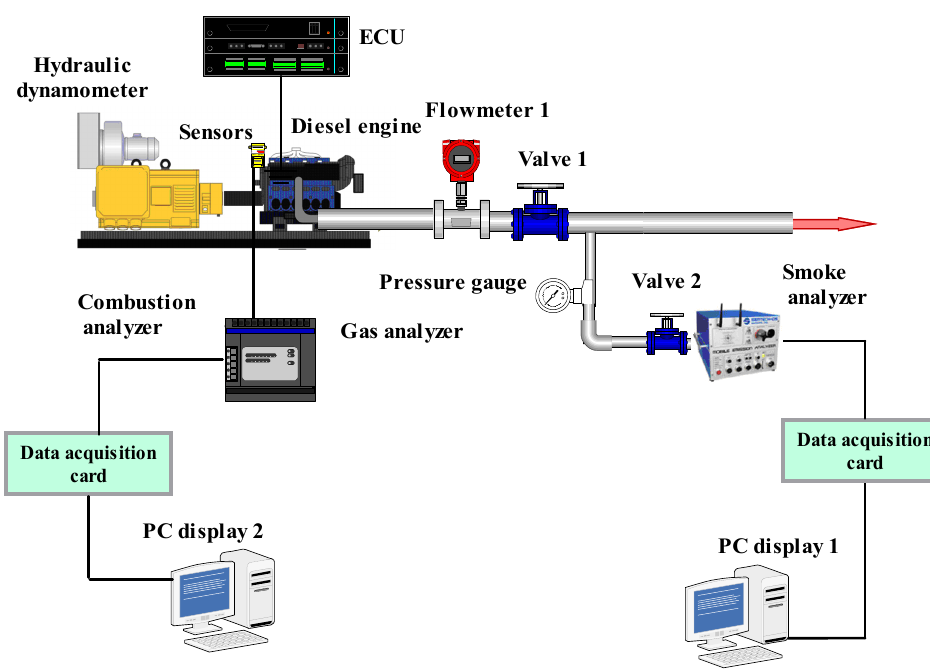
Figure 2. Schematics of experimental device.